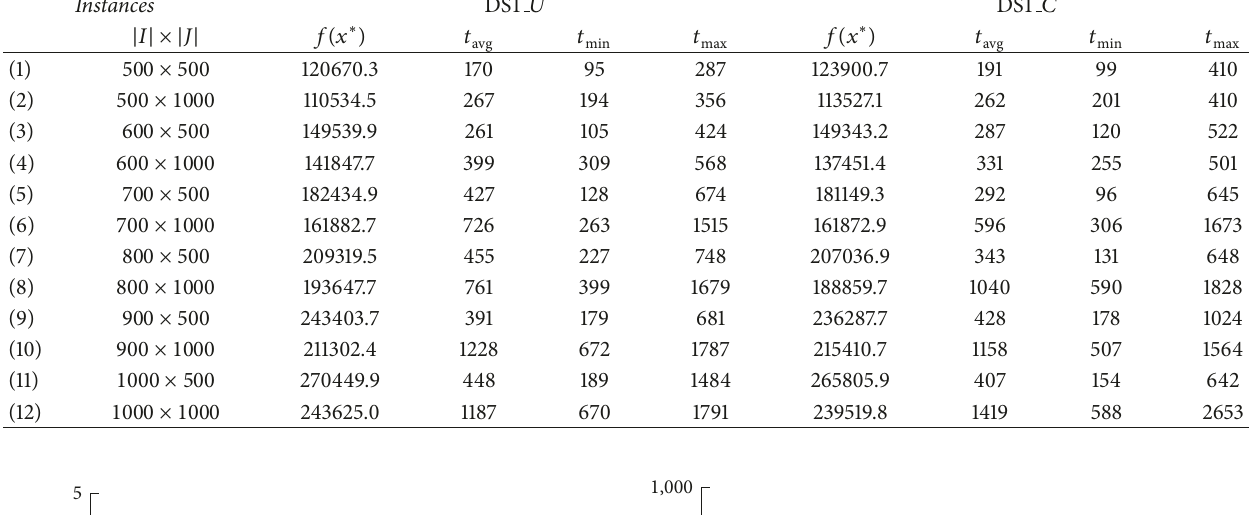
Table 2: Instances for the DS 1 𝑈 and DS 1 𝐶 benchmarks.